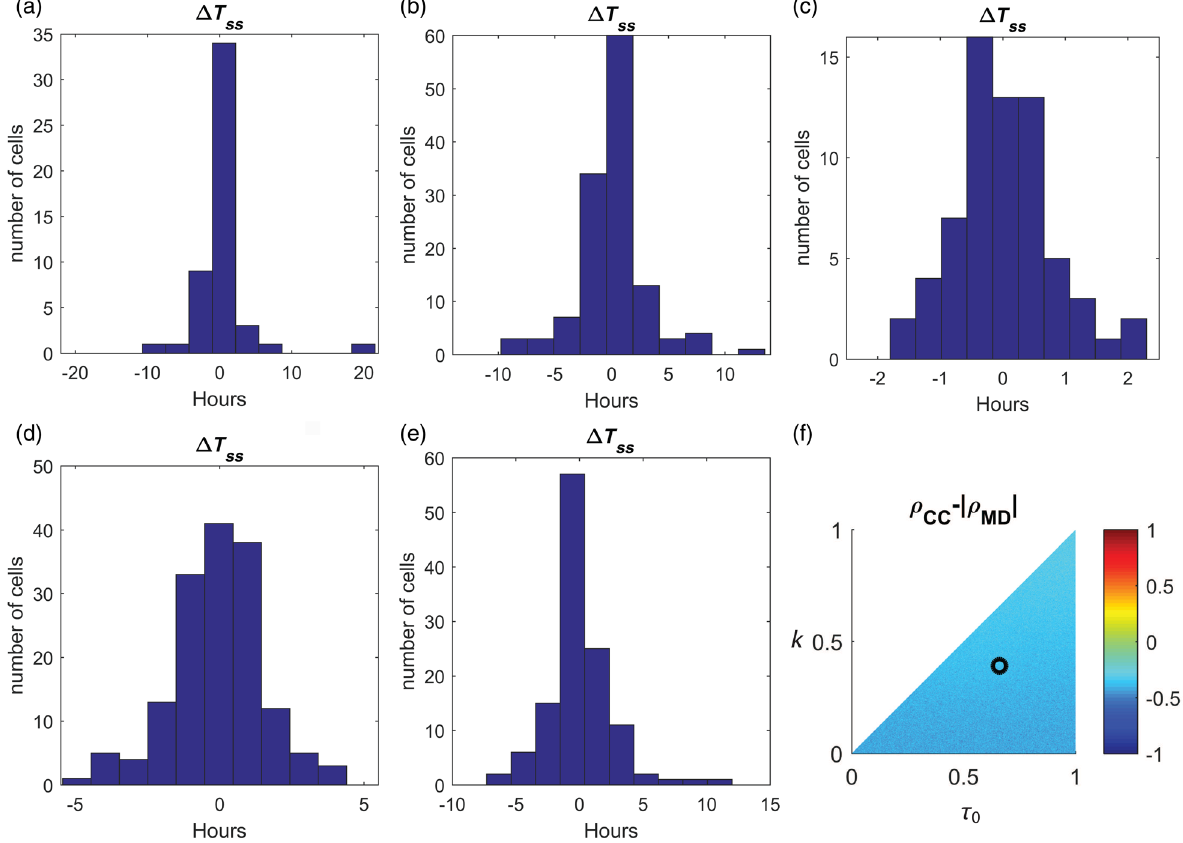
FIG. 8. Histograms of the experimental noise [ Δ T ss from Eq. (9)] for all data sets with large Δ (Tables 1 and 2): (a) Cyanobacteria 1, (b) Cyanobacteria 2, (c) EMT6, (d) Lymphocytes 1, and (e) Lymphocytes 2. (f) Visualization of the cousin-mother inequality [Eq. (8)] for a noise level of ξ ¼ 0 . 5 and α ¼ − 0 . 5 . The parameters are the same as for Figs. 3(b) and 3(c), except for a greater noise level. Note that, at this high noise level, the periodic forcing features disappear and the cousin-mother inequality is not